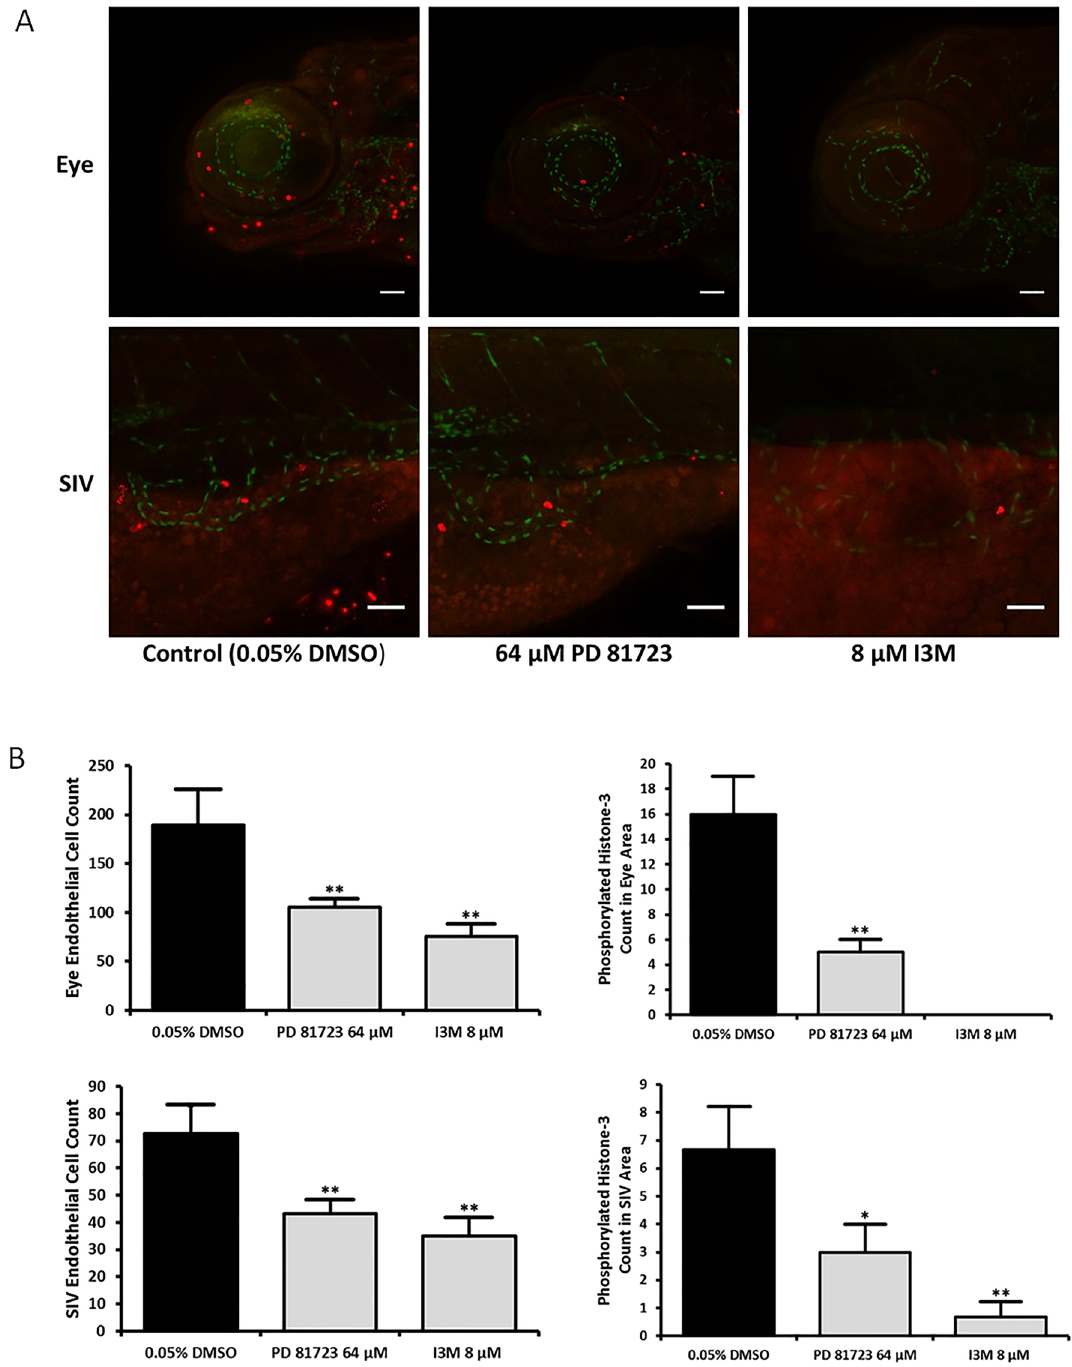
Figure 5. Phosphorylated H3 staining in SIVs and ocular area of 4 dpf zebrafish. ( A ) Representative images of SIVs and the ocular area of 4 dpf zebrafish treated with 0.05% DMSO, 64 µM PD 81,723, and 8 μM I3M at 10–11 hpf. Scale bars are 50 µm. ( B ) Graphical representations of the results from three different groups for the phosphorylated H3 stains that were repeated in triplicate with an N = 3 for each group. The error bars represent the standard deviation of the means from the three experiments. The number of endothelial nuclei was significantly reduced in both regions of interest in all instances of this experiment (** = P < 0.01 vs. control). A significant reduction in mitotic activity in the tissue surrounding the ocular vasculature (** = P < 0.01 vs. control) and the SIVs (* = P < 0.05 vs. control) in PD 81,723 fish was observed, when compared to the DMSO